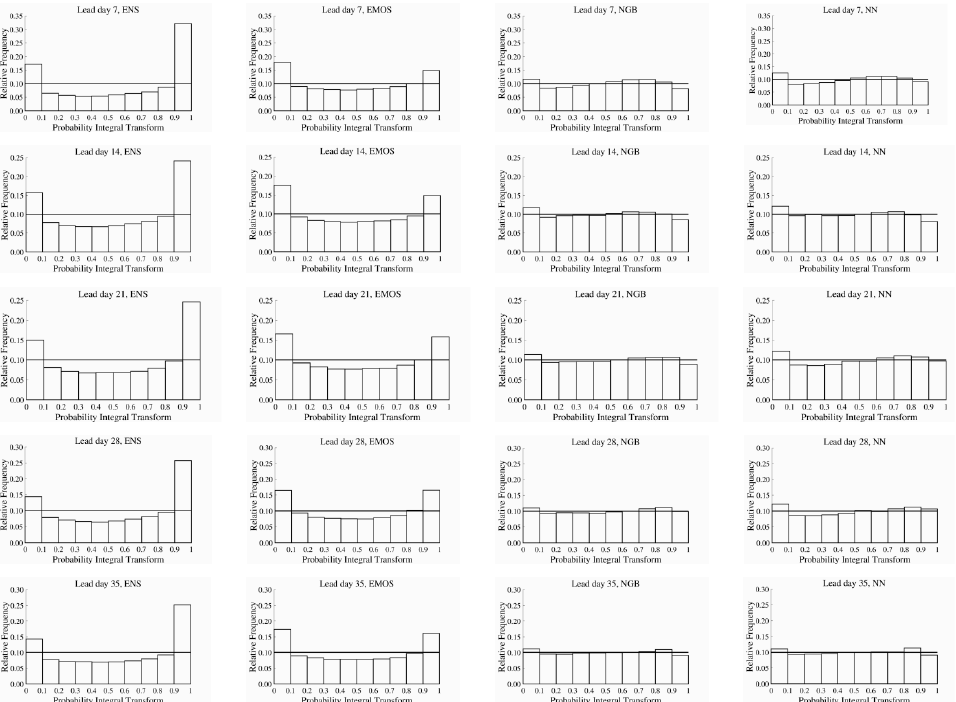
Figure 5. Probability integral transform (PIT) histograms of extended range 2-m maximum air temperature probabilistic forecasts for all land grid points over East Asia using different post-processing methods at different lead times. ENS, raw ensemble; EMOS, ensemble model output statistics; NGB, natural gradient boosting; NN, neural networks.